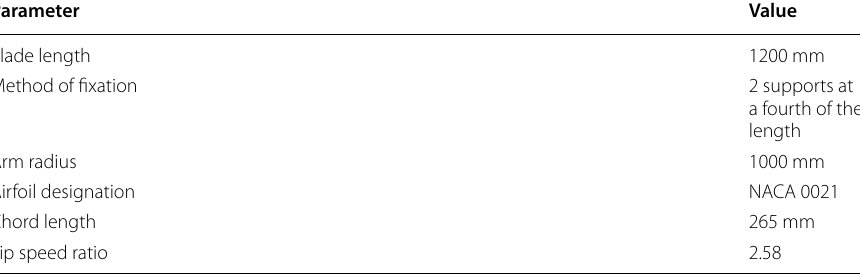
Table 3 Wind turbine parameters and operating conditions